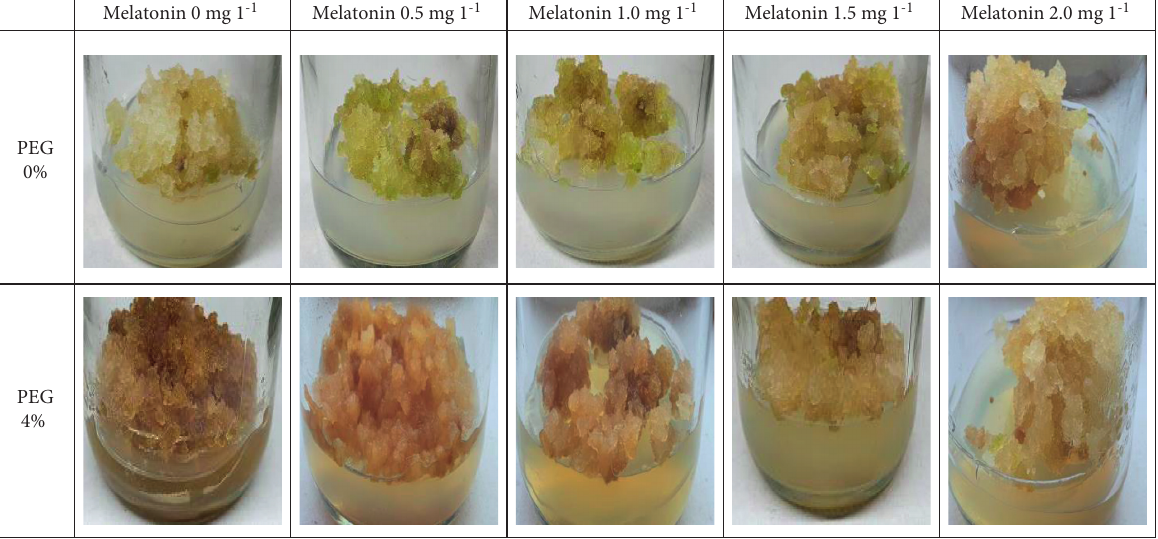
Figure 1: Morphological changes and biomass traits in melatonin treated H. pusillus callus cultures on medium with or without